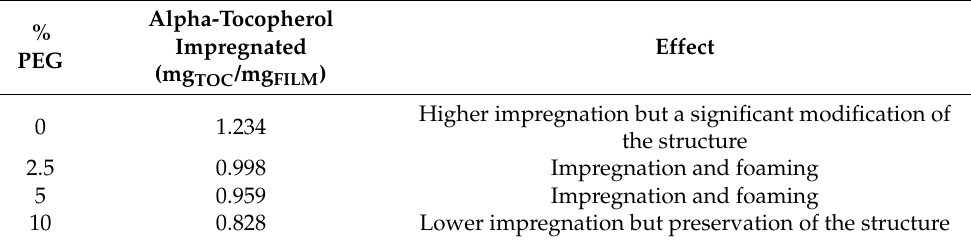
Table 3. Kinetics of impregnating alpha-tocopherol in PCL films by casting varying % of PEG [set at impregnation time 24 h, at 250 ◦ C and 170